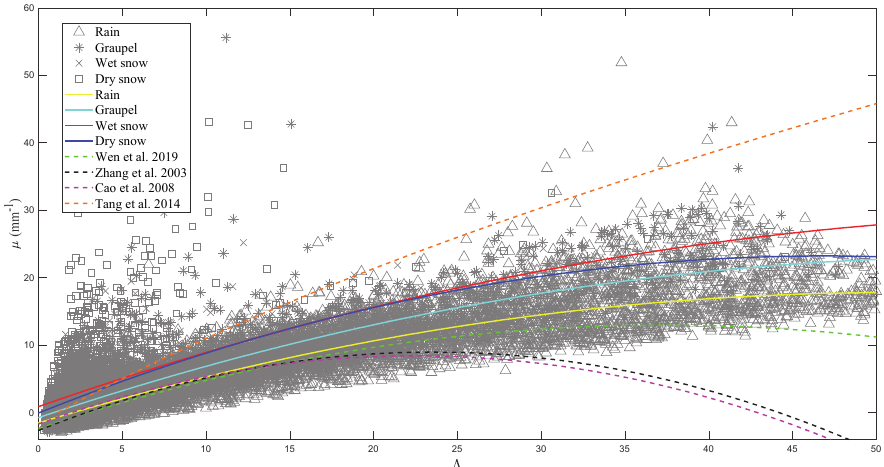
Figure 5. The scatter distributions of µ – Λ (gray triangle, asterisk, cross, square) and µ – Λ fitted functions (yellow, cyan, wet snow and dry snow solid lines) of rain, graupel, wet snow and dry snow, respectively. The four dashed lines are derived from the µ – Λ relationship calculated by predecessors. The details are shown in Table 5. Table 5. The μ – Λ relationships among different types of precipitation and previous studies.